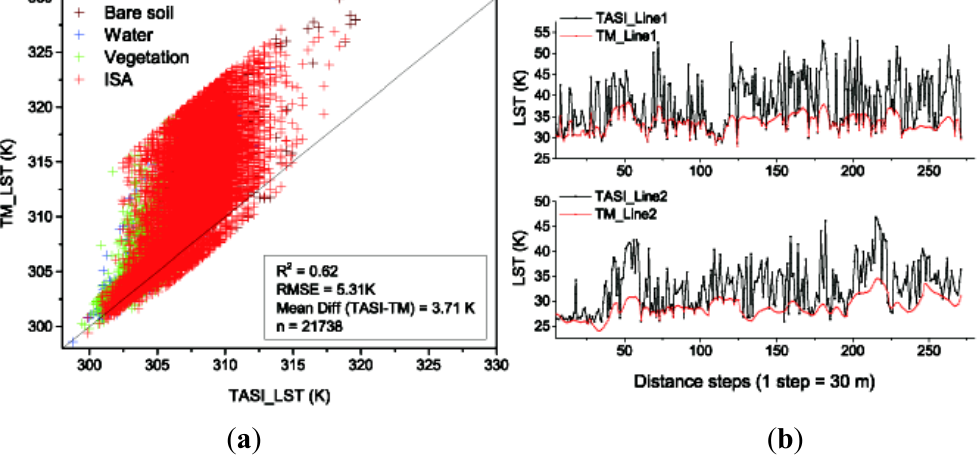
Figure 13. Comparison of the LST from TASI and Landsat TM on 15 August 2010 ( a ) Scatter plot of the LST; ( b ) the LST profile on two line transects (Lines marked in Figure